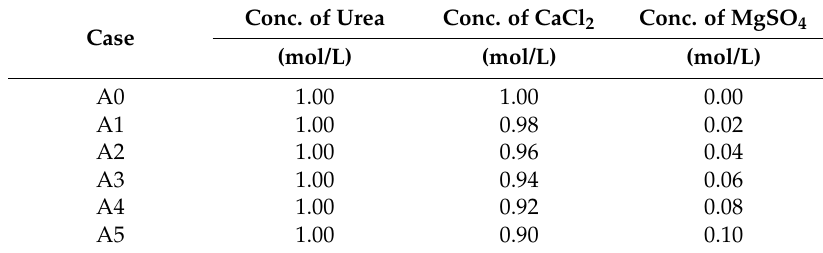
Table 1. Experimental conditions for test tube experiments to evaluate the effect of magnesium. Conc. of Case